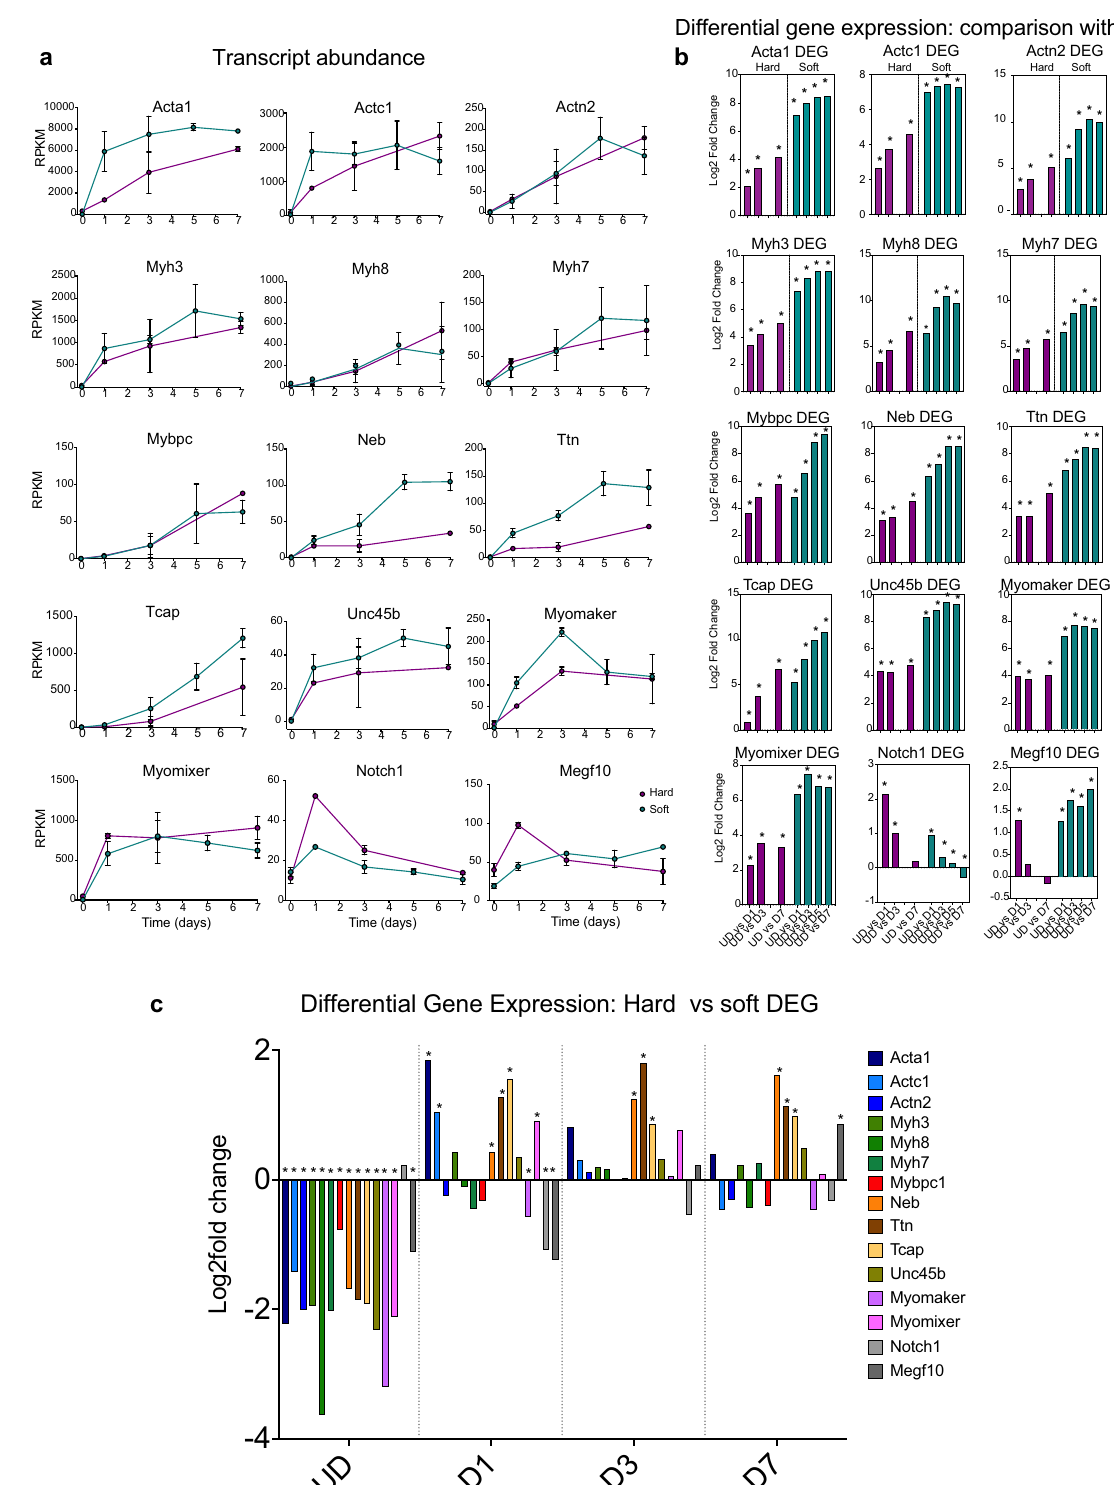
Figure 6. Expression of sarcomeric genes on hard or soft surfaces in C1F cells. ( a ) RPKM plots for hard (magenta) and soft (green) surfaces over time. Day 0 (D0) represents undifferentiated cells (UD). Days 1–7 represent the time course of differentiation. Error bars show the standard deviation (S.D.). ( b ) Differential gene analysis (DEG) that compares expression for each gene on over time, comparing UD with F1 etc. for cells cultured on hard and on soft surfaces. *Indicates significant change in log 2 fold expression (p adj value < 0.05). c: DEG comparing expression of each gene for cells cultured on hard versus soft surfaces, at each time point. *Indicates significant change in log 2 fold expression (p adj value <